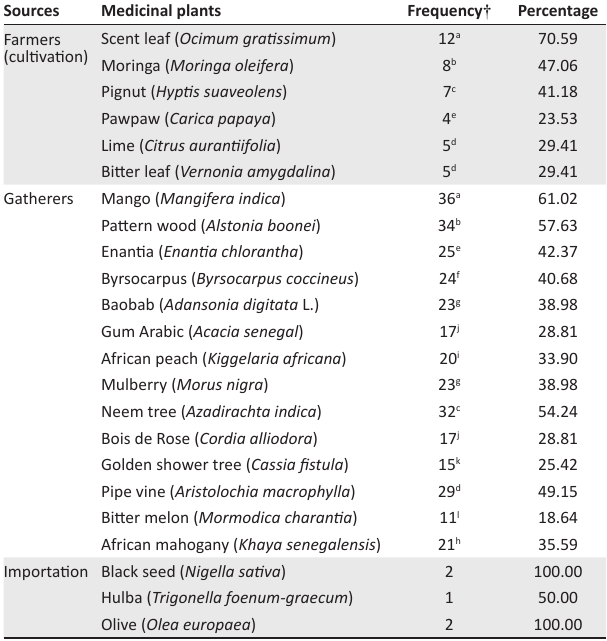
TABLE 2: Major types of medicinal plants supplied in the